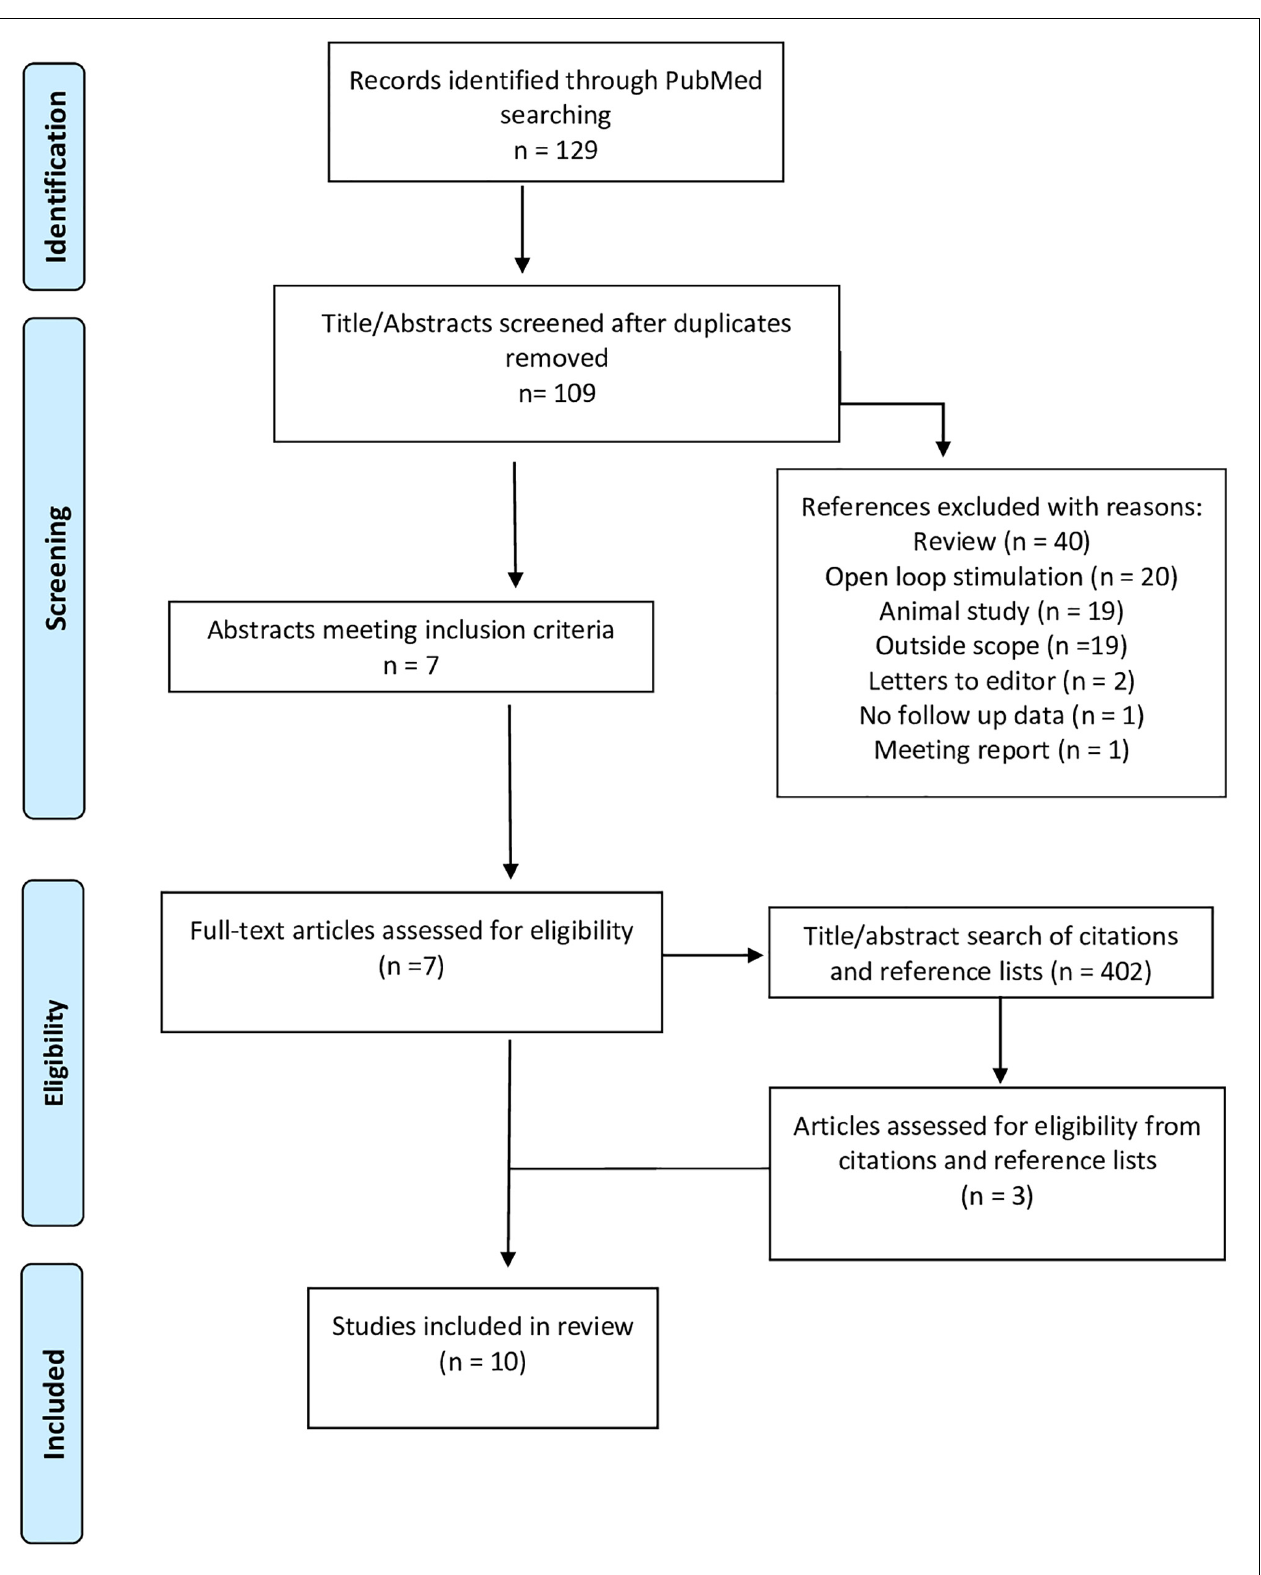
FIGURE 1 | PRISMA flow